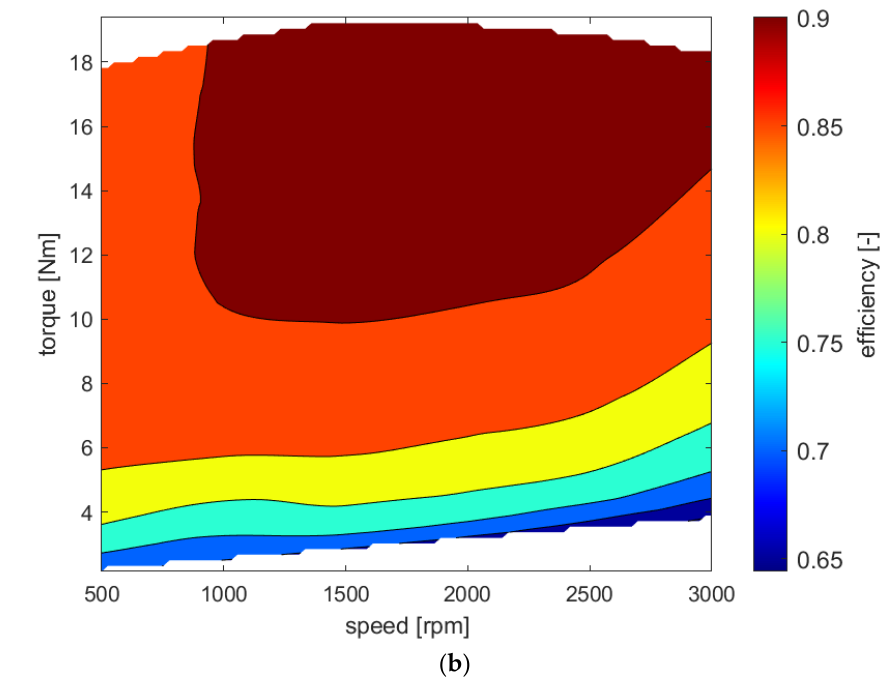
Figure 24. Efficiency points of the main motor of the crane drive ( a ) and the trolley travel and jib rotation drive ( b ) on the torque characteristics as a function of